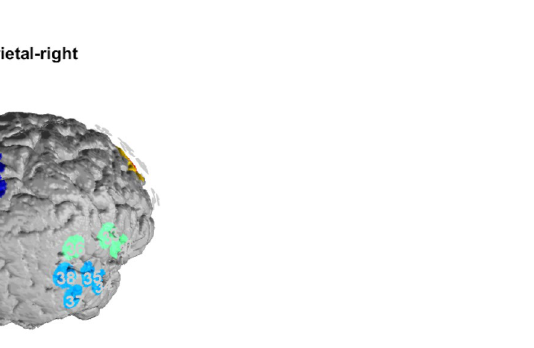
Figure 2. Channel positions and regions of interest (ROI). Red = frontopolar channels, Yellow = dorsolateral prefrontal cortex, light blue = temporal areas, dark blue = somatosensory association